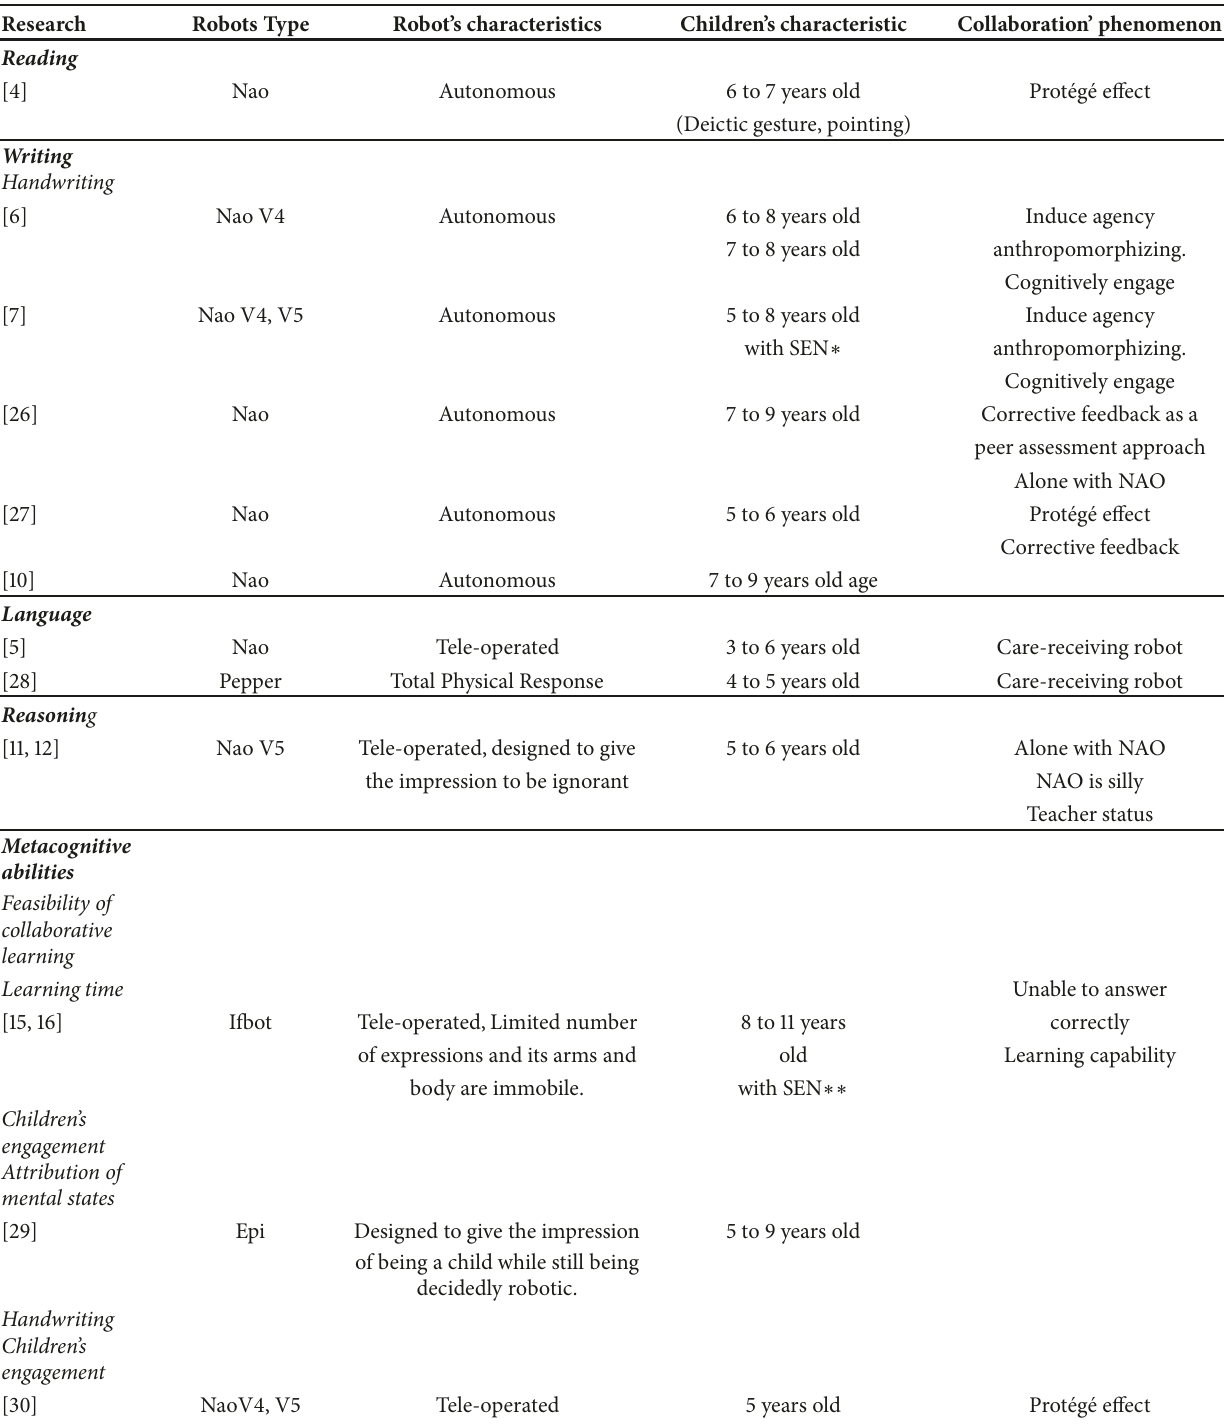
Table 1: Main studies of Learning by Teaching according to the characteristics of the “pupil robot” and the “child teacher”.